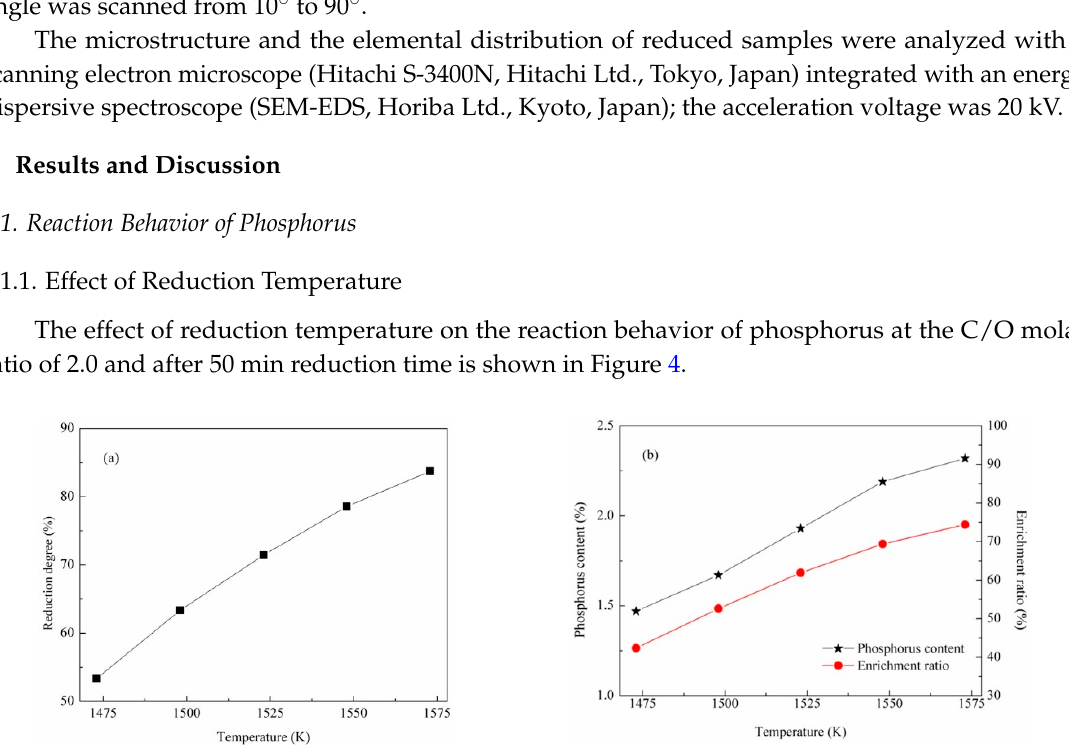
Figure 4. Effect of reduction temperature on the reaction behavior of phosphorus: ( a ) reduction of apatite to phosphorus; and ( b ) phosphorus enrichment in reduced iron.